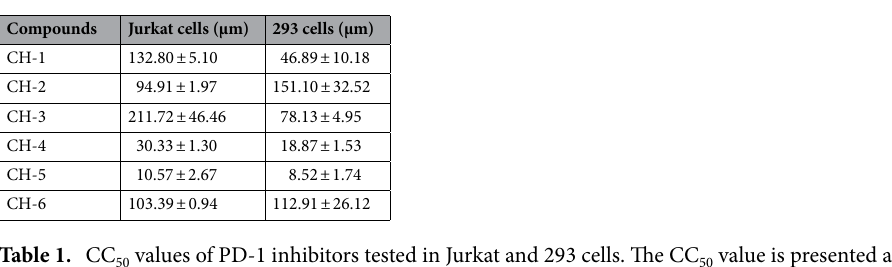
Table 1. CC 50 values of PD-1 inhibitors tested in Jurkat and 293 cells. The CC 50 value is presented as the mean ± standard